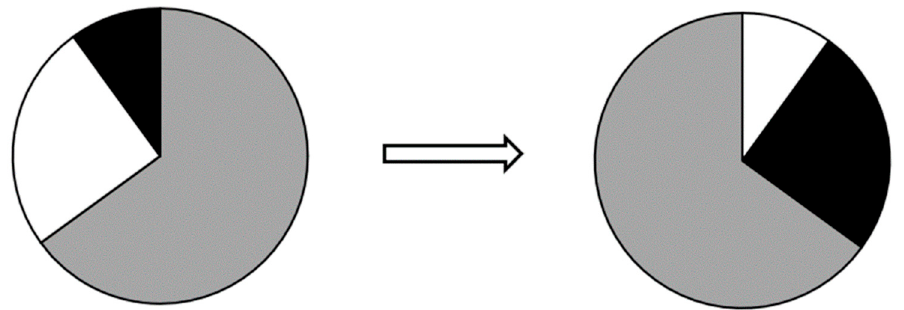
Figure 1. A diagram of the process of information whitening in the grey system theory (the colors of grey system models: White, grey and black). Source: Own elaboration based on Dytczak Ginta 2014.